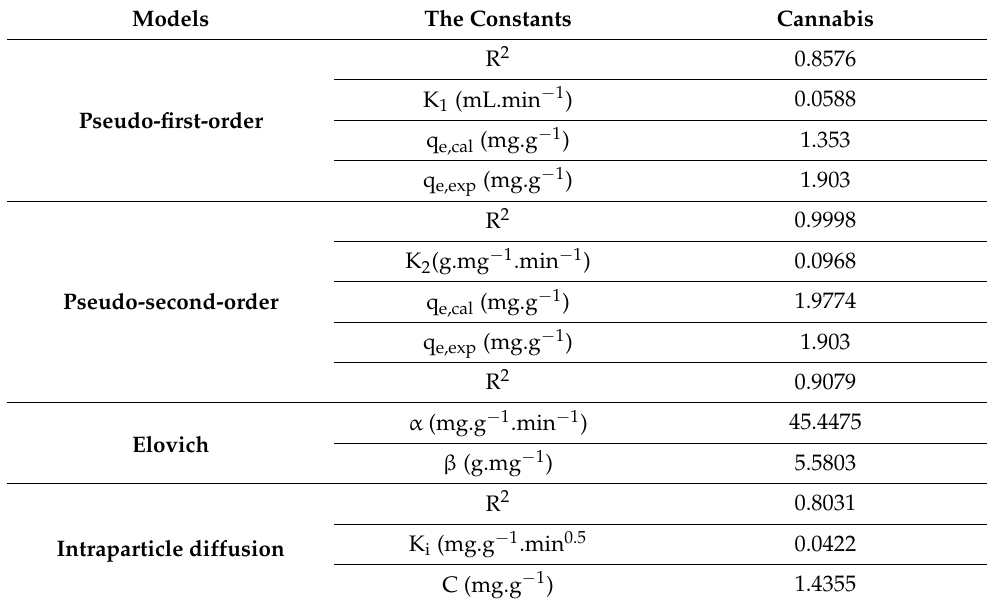
Table 4. Adsorption kinetics constants of BET dye on activated carbon cannabis (temperature = 20 ± 1 ◦ C, mass of adsorbent = 10 mg, initial concentration of dye = 10 mg.L − 1 ; stirring speed = 150 rpm and pH = 7 ±